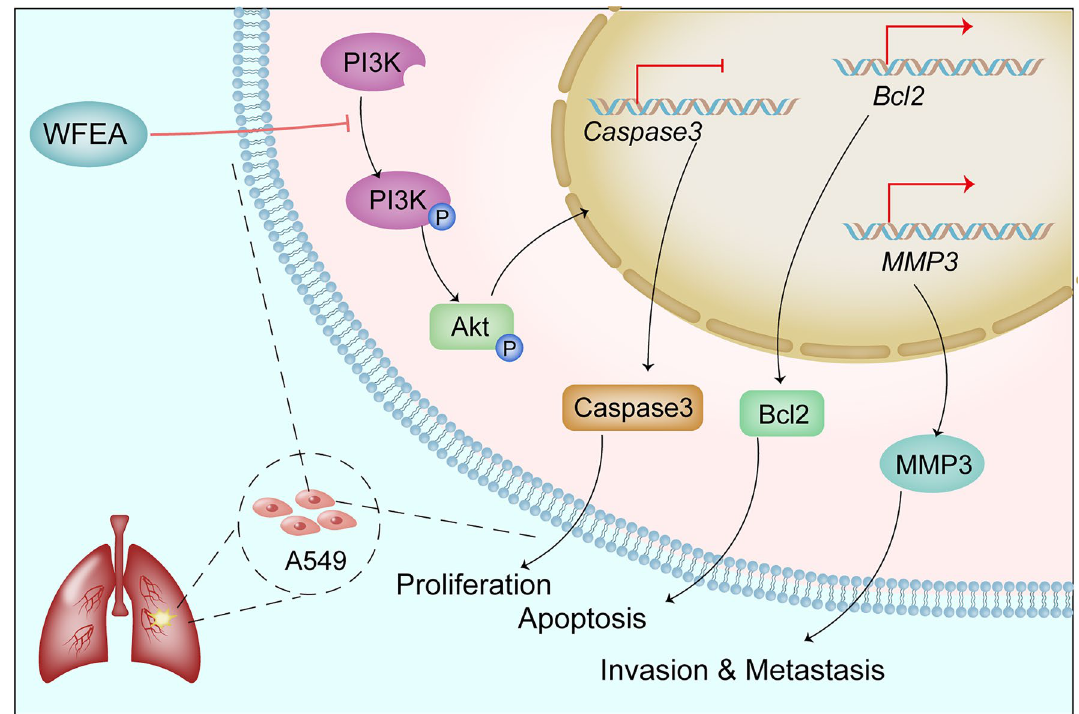
Figure 12. The sketch of the PI3K-Akt signaling